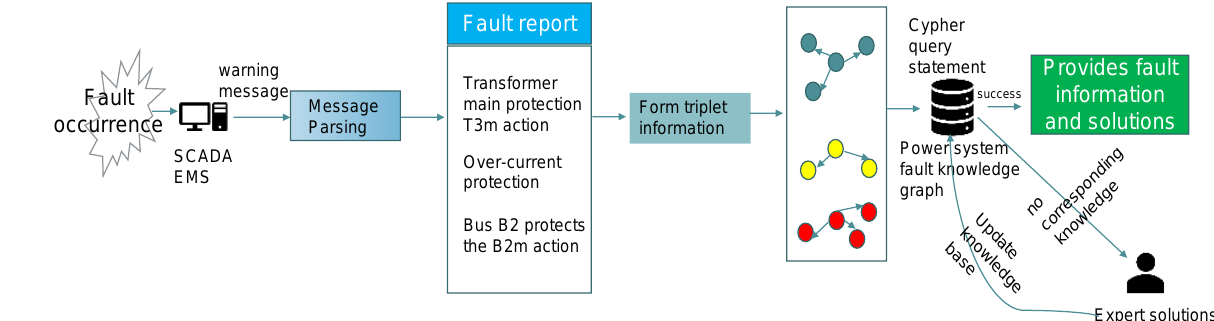
Figure 10. Application process of knowledge graph.